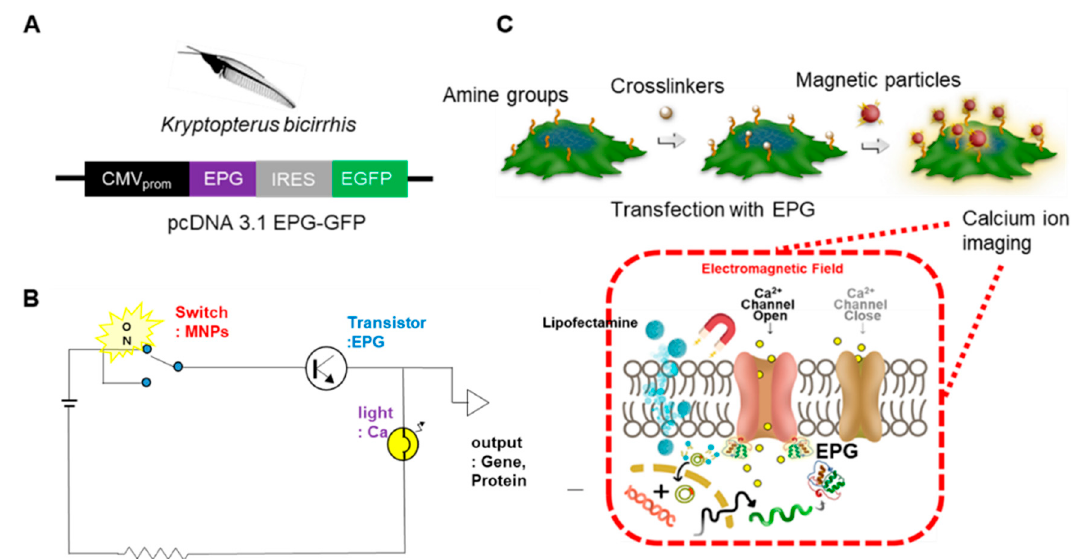
Figure 1. Illustration of the remote regulation of [Ca 2+ ] i in human embryonic kidney (HEK EPG+GFP ) cells. ( A ) Plasmid encodes of both the electromagnetic perceptive gene (EPG) and the Green fluorescent protein (GFP) using Internal ribosome entry site (IRES) under the regulation of a general cytomegalovirus promotor (CMV promoter) were constructed. ( B ) Scheme of engineering biological circuit; switch = magnetic particles, transistor = EPG, light = Ca imaging, output = target gene/protein. ( C ) EPG+GFP was expressed in HEK293T. Sulfo-NHS-SS-Biotin was used to crosslink biotin with amine groups of cell-surface proteins. Streptavidin-coated Manetic particles (MPs) were added to the media and conjugated to biotin moieties on the cells (MPs are located outside of cells). [Ca 2+ ] i imaging was employed to monitor the cell activation profiles with magnetic stimulation. EPG is a transmembrane protein; the origin of the Ca ion before the magnetic stimulation of cells is unknown; Ca ion is mainly stored in Endoplasmic reticulum (ER) but the uptake of Ca ion should be